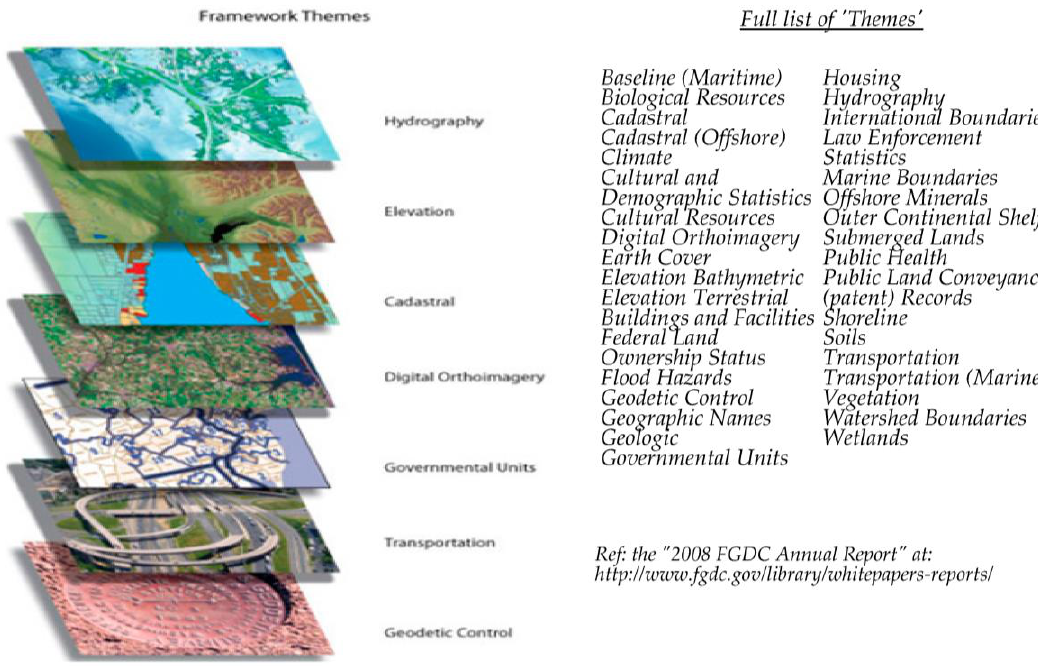
Figure 3. The many themes identified by the Federal Geographic Data Committee, collected by US agencies.